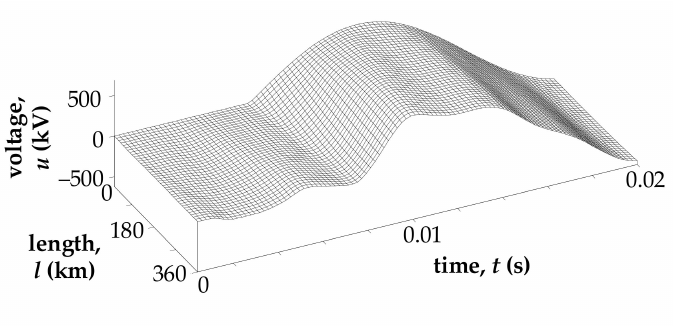
Figure 13. Space-temporal distribution of phase B voltage at the time t ∈ (0; 0.02) s.